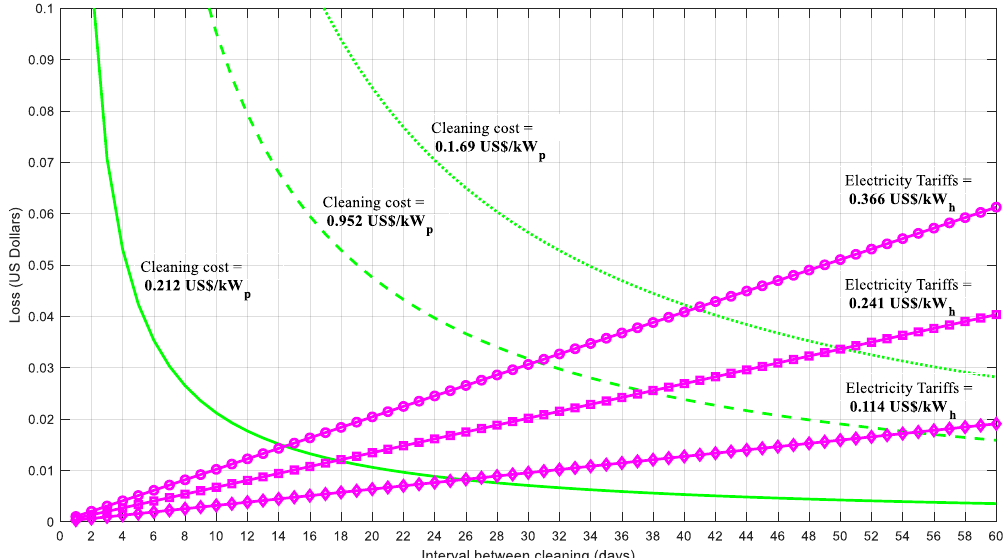
Figure 10. Average daily losses due to the three different cleaning costs (inversely proportional curves) and the dust accumulation (linear curves) obtained by the optimized ELM model when the three different electricity tariffs are used.